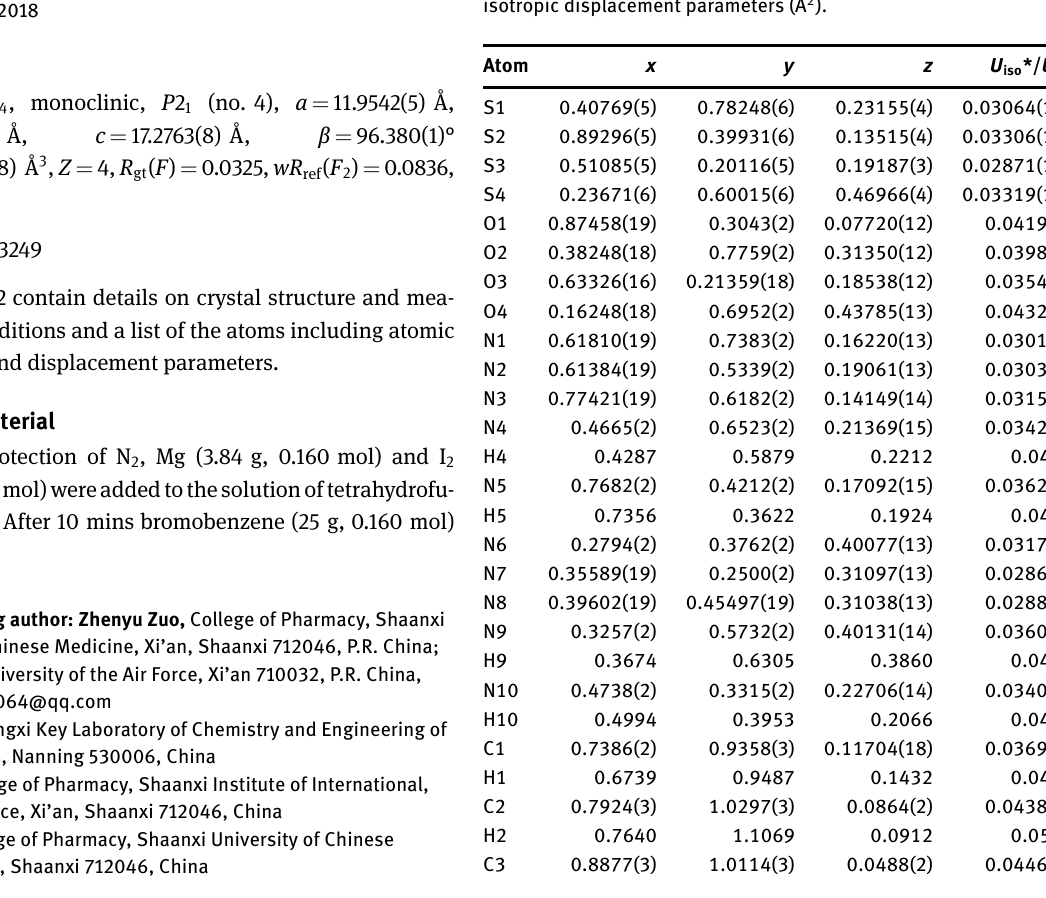
Table 2: Fractional atomic coordinates and isotropic or equivalent isotropic displacement parameters (Å 2